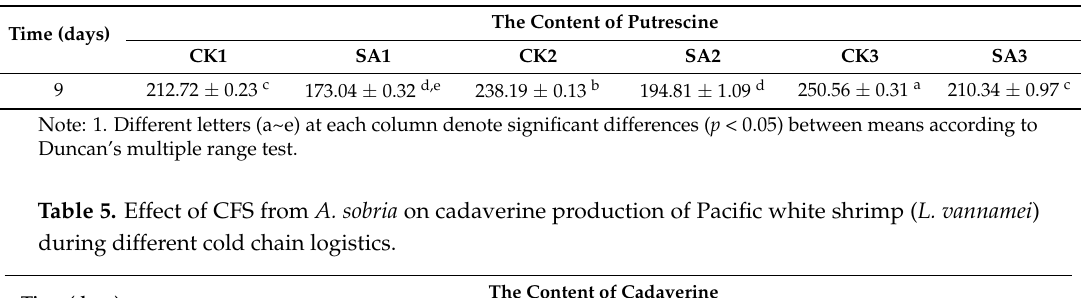
Figure 5. Effect of CFS from A. sobria on ( a ) putrescine and ( b ) cadaverine production of Pacific white shrimp ( L. vannamei ) during different cold chain logistics. Table 4. Effect of CFS from A. sobria on putrescine production of Pacific white shrimp ( L. vannamei ) during different cold chain logistics.